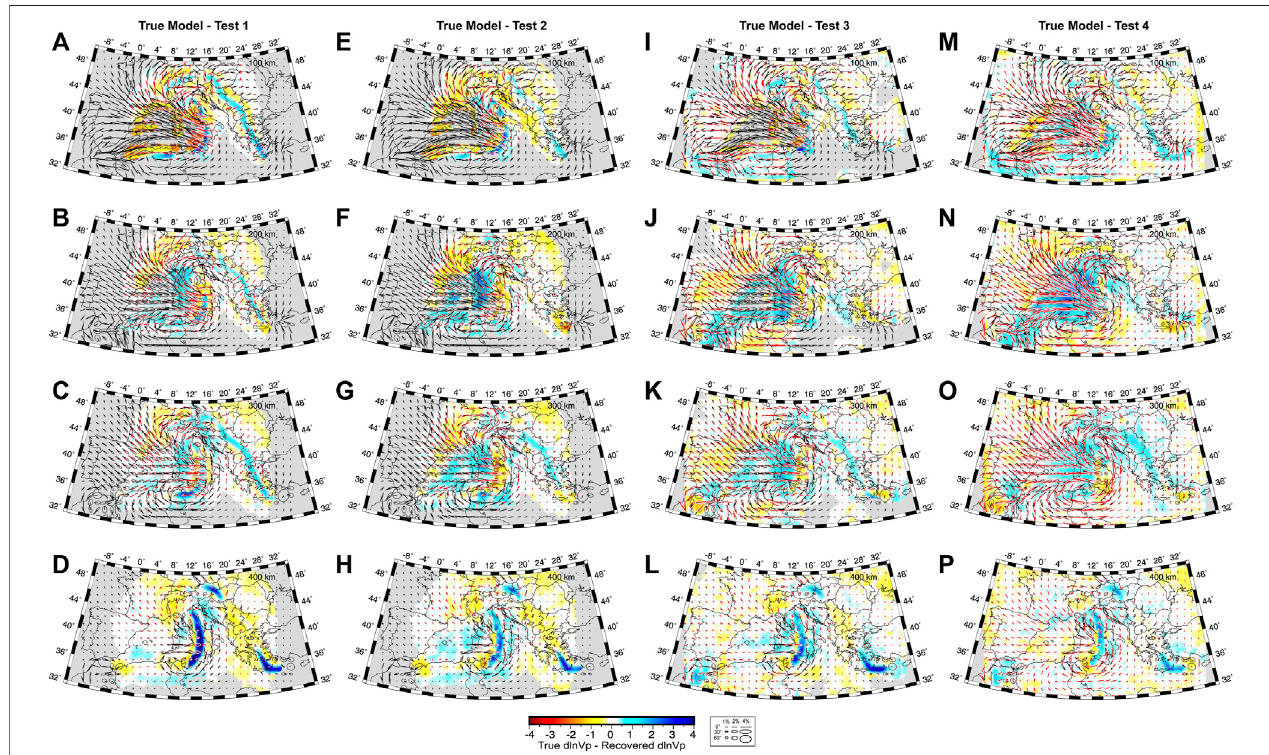
FIGURE9| Depth slicesat 100 km,200 km,300 kmand 400 kmshowingthedifferences betweenthetruemodeland (A – D) Test 1, (E – H) Test 2 (I – L) Testthree and (M – P) Test 4. Anisotropy is plotted using ellipses as described in Figure 6 . Areas of poor data coverage are masked in grey.